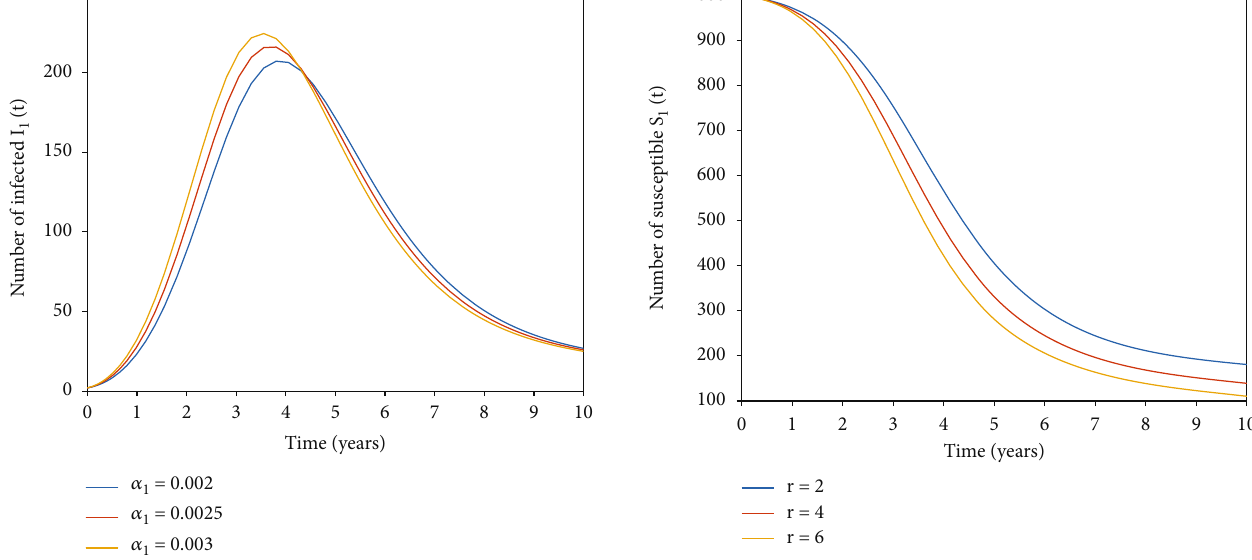
Figure 17: Transformation of susceptible individuals for constant injecting rate of UV index r with various